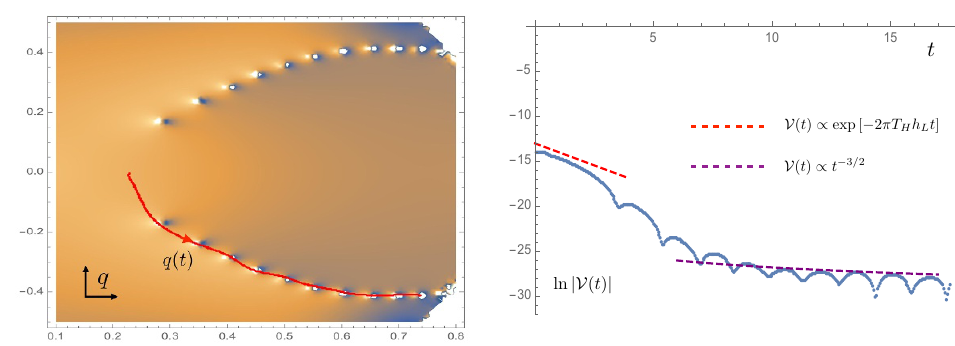
Figure 24 . Left: trajectory for x ( t ) = 1 r ( t ) e it in the q -plane, passing through the poles/zeros (cid:0) for p ( q )/ ( q ). Right: plot of ln ( x ( t )) , with an early exponential decay followed by \ripples" of V jV j approximately t (cid:0) 3 = 2 envelope. Parameters used: c = 30 ; h H = 5 ; h L = 1 = 2. S n ( (cid:18) ) is linear for all n (and for V A =V < 1 = 2), taking into account the full